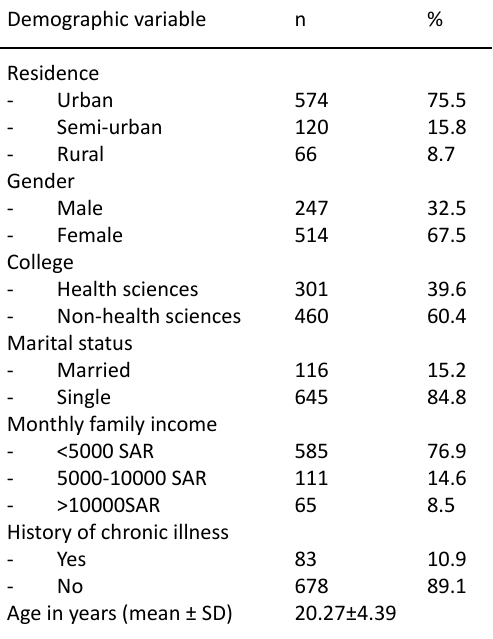
Table 1. Participants' demographic variables (n= 761) Demographic variable